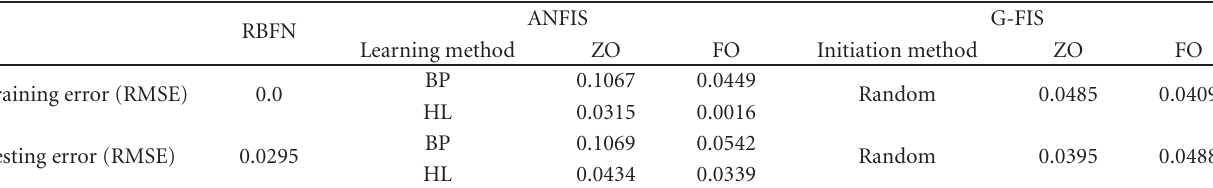
Table 5: A summary of the training and testing